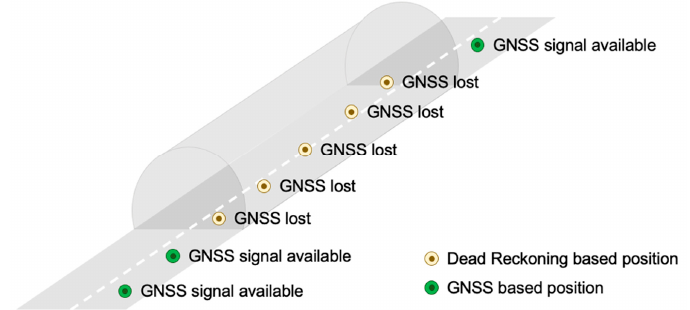
Figure 1. Utilization of Dead Reckoning.